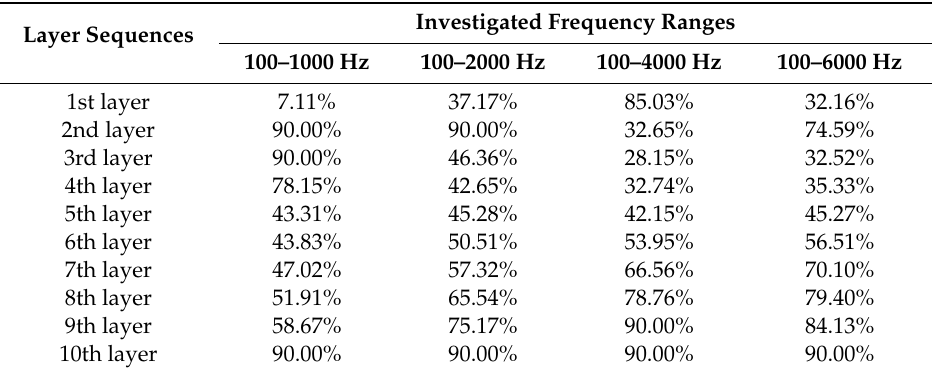
Table 1. Summary of compression ratios of each layer in the optimal 10-layer gradient compressed porous metals with the di ff erent investigated frequency